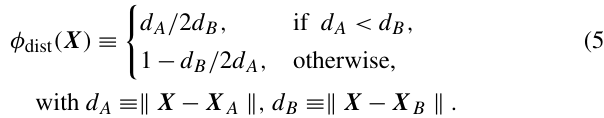
Figure 2. Illustration of the TAMS algorithm. First, simulate N tra- jectories starting in X A ( N = 3 blue trajectories in the figure). The trajectories are ranked according to their score φ i , which is the max- imum value of the score function φ along the trajectory. Then, at each iteration, the trajectory with the lowest score (1 in the figure, with score φ 1 ) is discarded. It is replaced by picking a trajectory uniformly at random from the other ones (2 in the figure), then com- puting the earliest position at which it reaches a higher score than the discarded trajectory (orange dot) and finally using this position as the branching point for the new trajectory (1 (cid:48) ). This is repeated until all the trajectories reach B or the number of iterations reaches a predefined